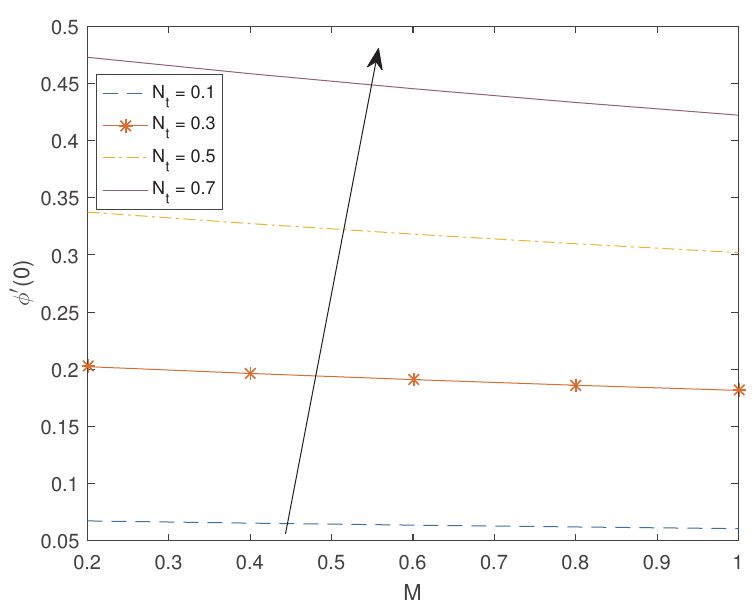
Figure 22. Influence of M and N t on the mass transfer.